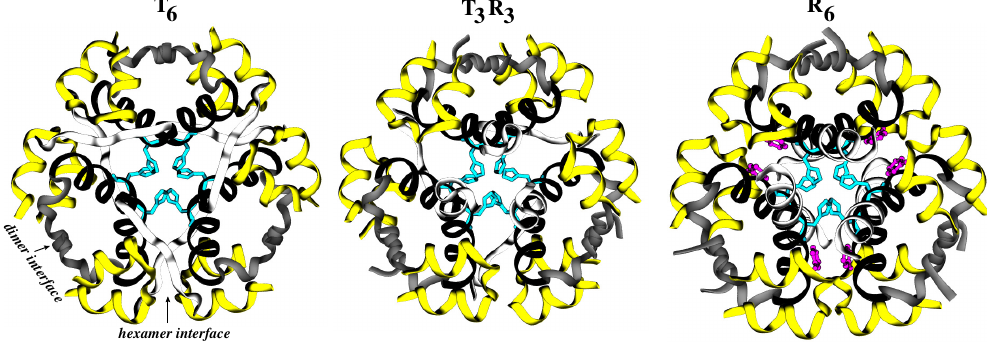
R , T and R insulin hexamers 6 3 3 6 only) are shown in stick representations. Disulfide 6